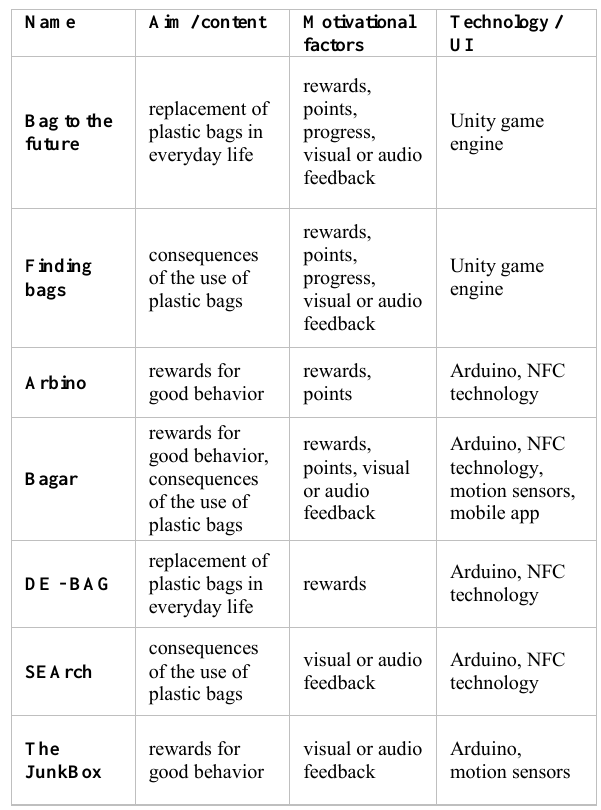
Table 2. The eight implemented projects with their aims and content, motivational factors and technology – user interface